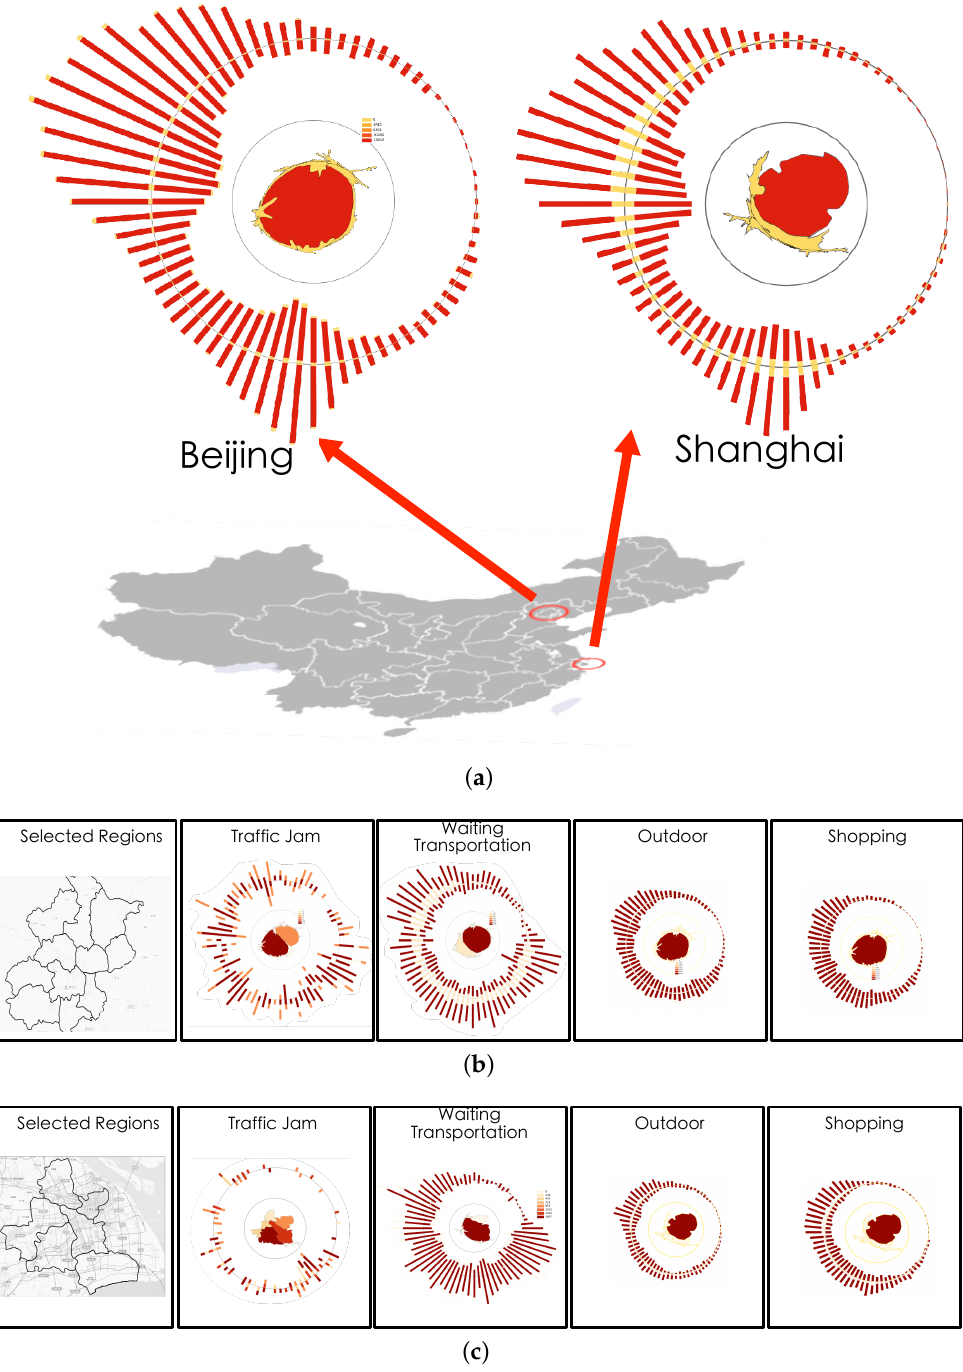
Figure 9. Case 2. The comparison of two activities which show quite different spatial and temporal patterns. ( a ) Two city’s dinning activities fingerprinting comparison. We can easily identify that the temporal trends in two cities differ slightly from each other. The two cities lunch time is closer to 2 p.m. rather than the traditional 12 p.m., however Beijing starts a little earlier and the active period in the night is a little longer than Shanghai; ( b ) Beijing selected activity fingerprinting. Many activities occur in a hot spot, frequent places in geographic spaces or a permanent region. However, we identified that waiting for transportation is an activity that high correlates to the traffic jams in Beijing; ( c ) Shanghai selected activity fingerprinting. We found that many activities occurred in hotspots or frequent places in spatial domains but unlike Beijing, Shanghai’s traffic jams are equally distributed over the whole